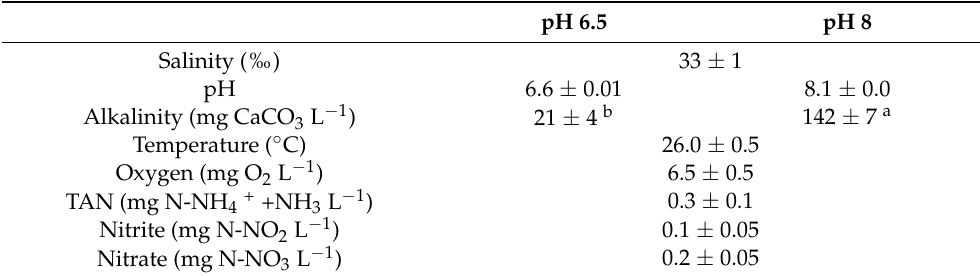
Table 2. Trial 2—Water conditions (mean ± standard deviation) for the maintenance of H. reidi (21–49 DAR—days after the male’s pouch release) reared in seawater (SW—salinity 33) at pH 6.5 or 8.0 for four